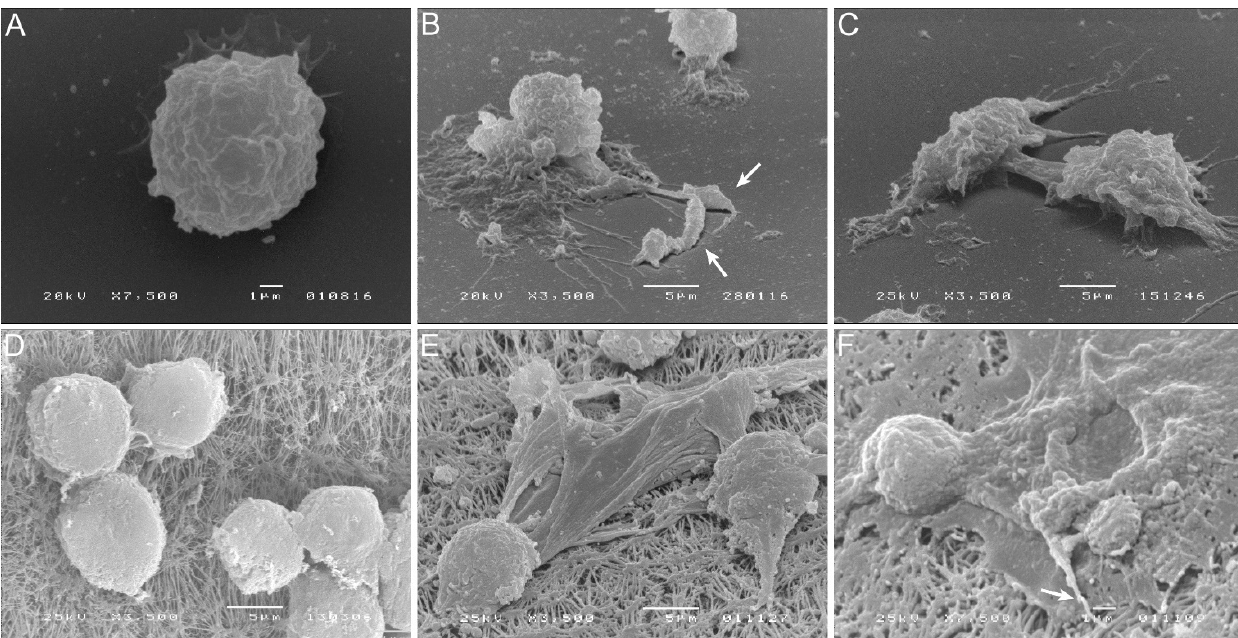
Figure 5. Blood-MØs phagocyting promastigotes and KCs emitting extracellular traps (ETs) in response to L. infantum . Uninfected blood-MØs ( A ) and blood-MØs exposed to virulent L. infantum promastigotes for 3 h ( B , C ) were observed by SEM and images were acquired. White arrows point out fiber-like structures entrapping promastigotes. Uninfected KCs ( D ) and KCs releasing ETs after 5 h of incubation with L. infantum axenic amastigotes ( E , F ) can be observed. White arrows indicate a fiber-like structure and cytoplasm extravasation.